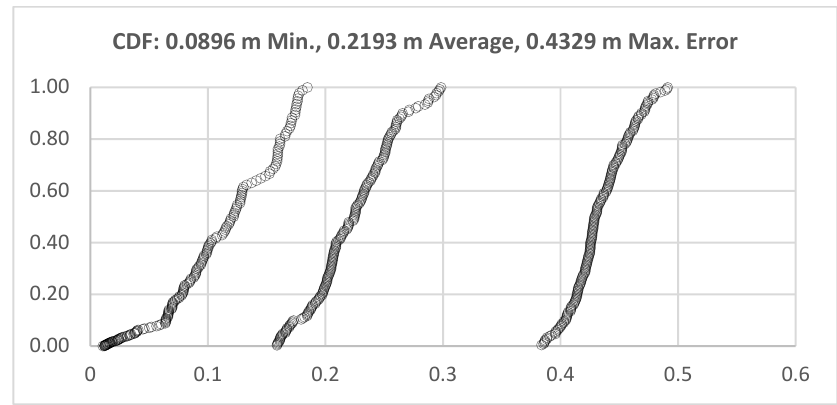
Figure 8. Behavior mapping test results of ultra-wide band sensors for 4680 measurements, the cumulative distribution function (CDF) of the test points of minimum, maximum and average localization errors determined by the UWB positioning system (23 test points inside; three test points outside, the test bed; and 180 measurements per point).